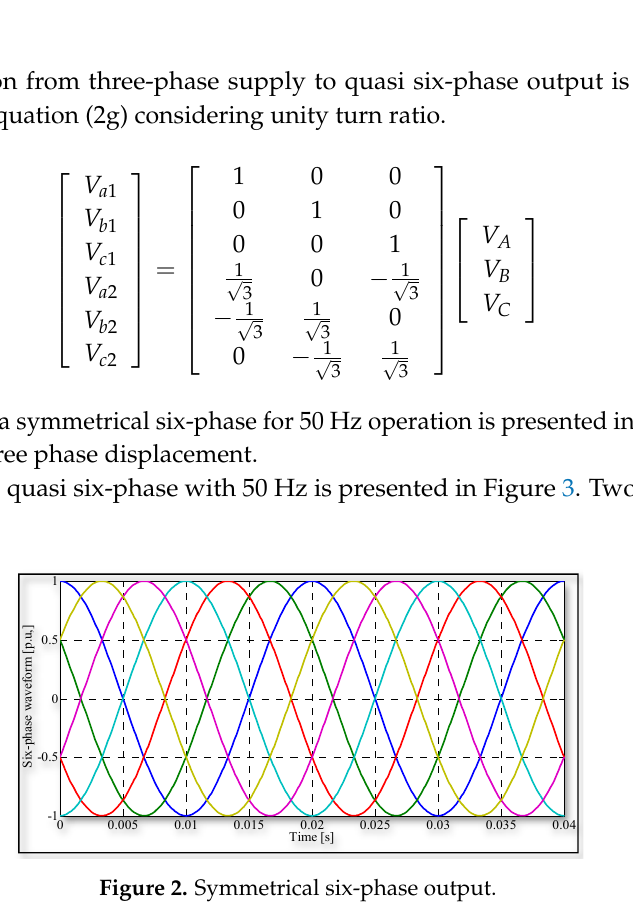
Figure 2. Symmetrical six-phase output.